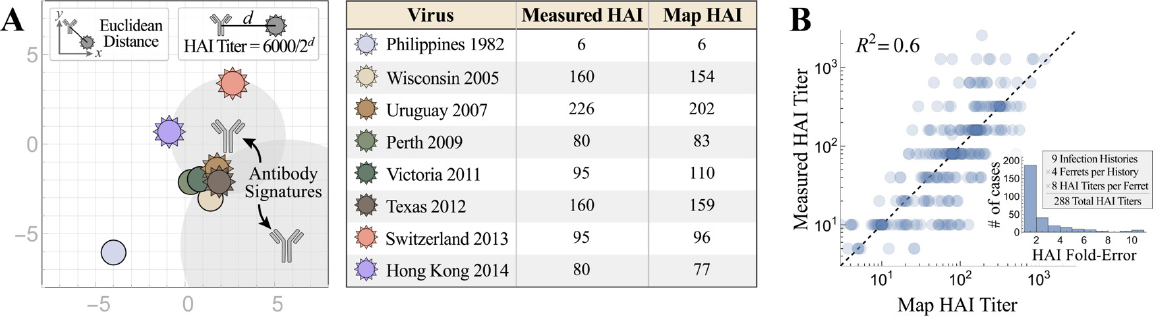
Figure 1. Characterizing the accuracy of Neutralization Landscapes. ( A ) The decomposition of ferret antiserum elicited by sequential H3N2 infections in a neutralization landscape (left) and the resulting predicted/measured HAI titers (right). Larger antibody–virus distance on the landscape corresponds to weaker antibody inhibition, with Euclidean distance d representing an HAI titer of 6000/2 d . The resulting antibody signatures represent the predicted inhibition profiles of the dominant antibodies within the serum. ( B ) Cumulative analysis for all ferret antisera analyzed in this work. The inset shows the distribution of fold-errors for these predictions. Second, while we decomposed ferret antiserum using the HAI titers against all eight viruses (Figure 2A), we also performed another decomposition by using the half set of measurements to predict the HAI titers against the remaining four viruses in the panel (Figure 2B; titers against red viruses were used for direct decomposition and titers against gray viruses were inferred from the map). Despite the difficulties of triangulating the coordinates and stoichiometries of multiple antibodies using a half set of the measurements, the predicted HAI titers were on average 6.0-fold off from the experimental measure- ments, only slightly larger than the 2.4-fold error when the full suite of titers was used for decomposition (Figure